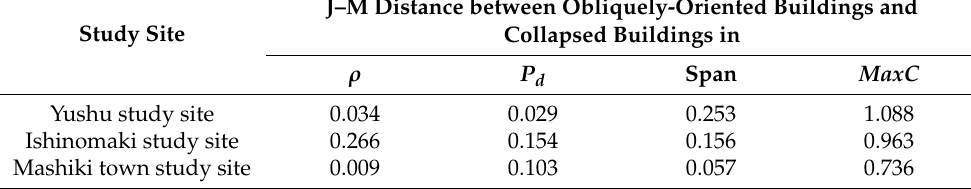
Table 1. Jeffreys–Matusita (J–M) distance between obliquely-oriented buildings and collapsed buildings in different features in three study sites. J–M Distance between Obliquely-Oriented Buildings and Study Site Collapsed Buildings